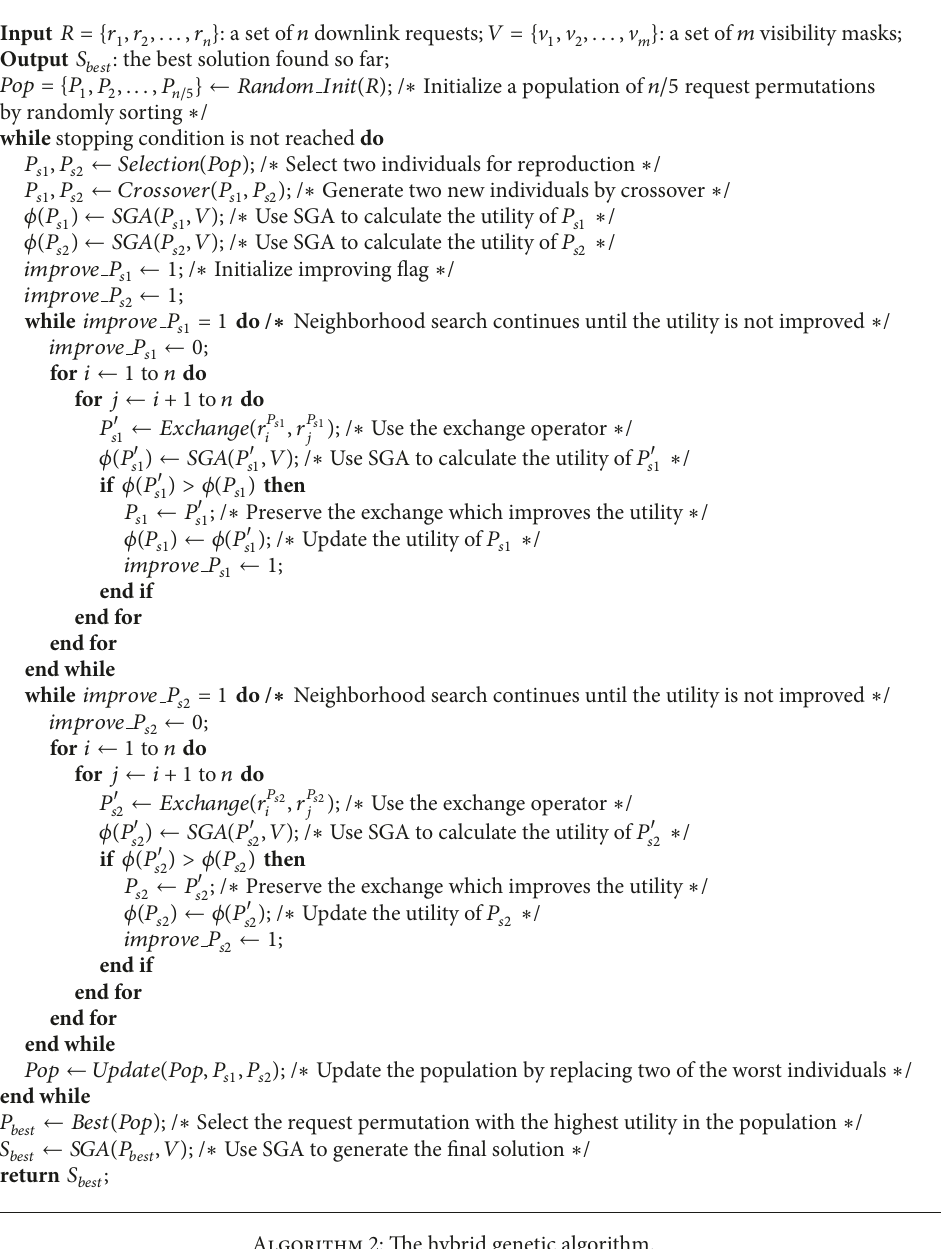
Algorithm 2: The hybrid genetic